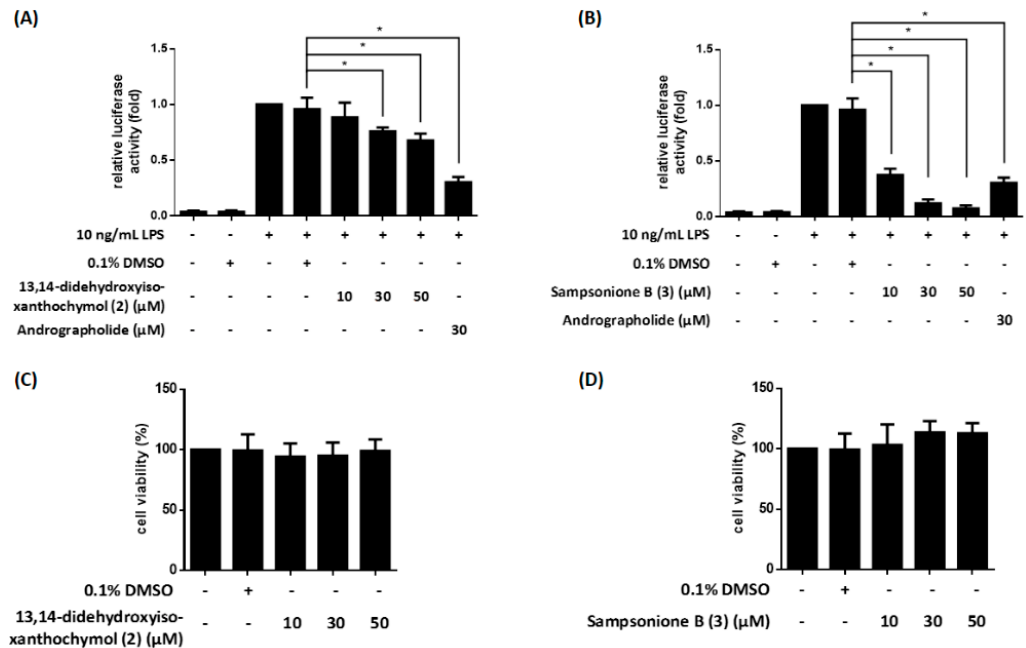
Figure 8. The compounds 2 and 3 inhibit NF- κ B activation in lipopolysaccharide (LPS)-induced RAW 264.7/Luc-P1 cells. The luciferase activities of 13,14-didehydroxyisoxanthochymol ( 2 ) ( A ) and sampsonione B ( 3 ) ( B ) in LPS-stimulated RAW 264.7/Luc-P1 macrophages were observed. Andrographolide is the positive control. The cell viability of RAW 264.7/Luc-P1 cells incubated with 13,14-didehydroxyisoxanthochymol ( 2 ) ( C ) or sampsonione B ( 3 ) ( D ) for 24 h was measured using MTT assay. * indicates significant difference vs. LPS-treated vehicle control ( p < 0.05).